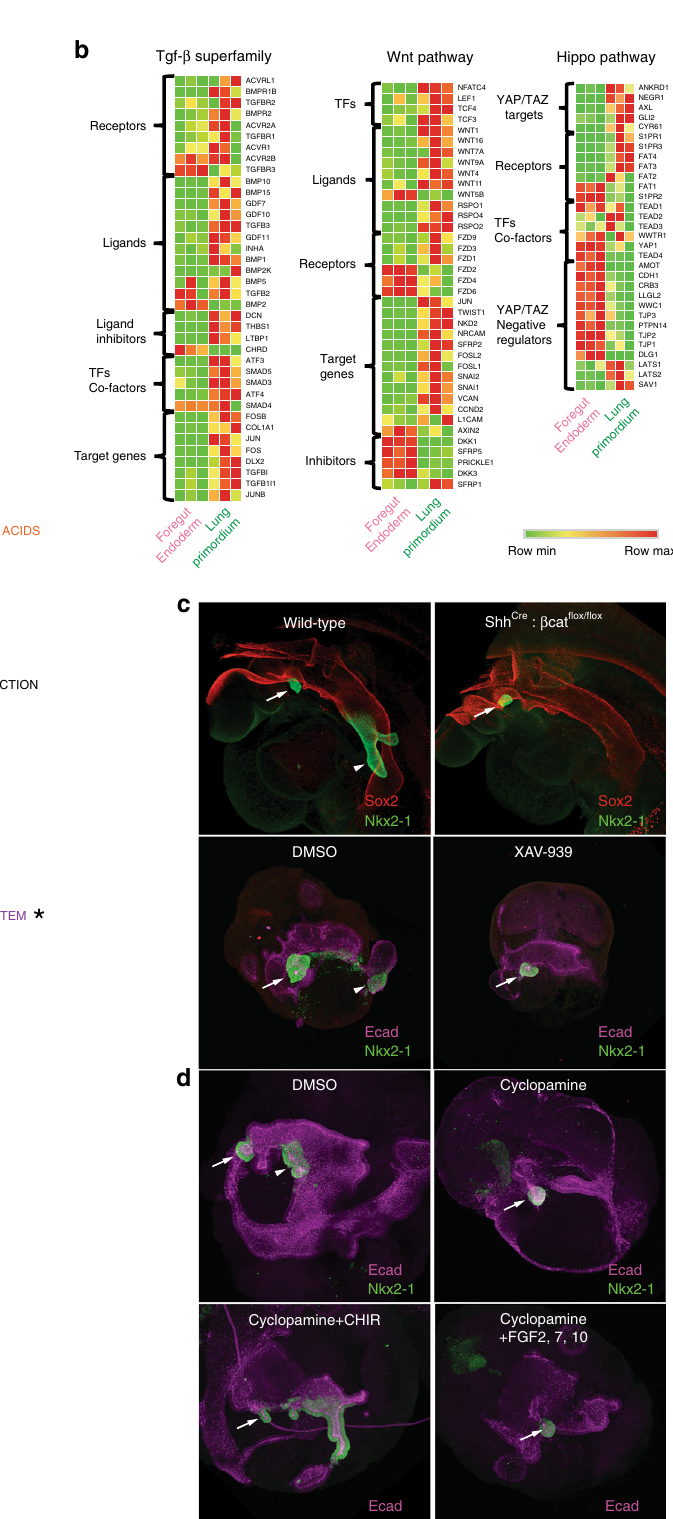
Wnt, Hippo, and Tgf- β pathways in in vivo lung speci fi cation . To delve into higher order biological processes that are unique to lung speci fi cation, we performed gene set enrichment analysis (GSEA) for all three Nkx2-1 + embryonic progenitors and their respective pre-speci fi ed populations (Fig. 4a; Supplementary Fig. 3A). Several pathways/processes appear to be common in either all three progenitor populations (e.g., “ Circadian